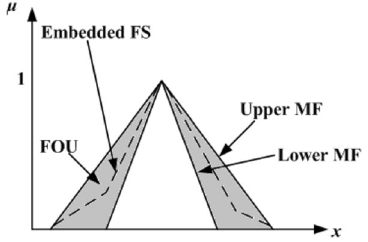
Fig. 5 Triangular interval type-2 FS ̃